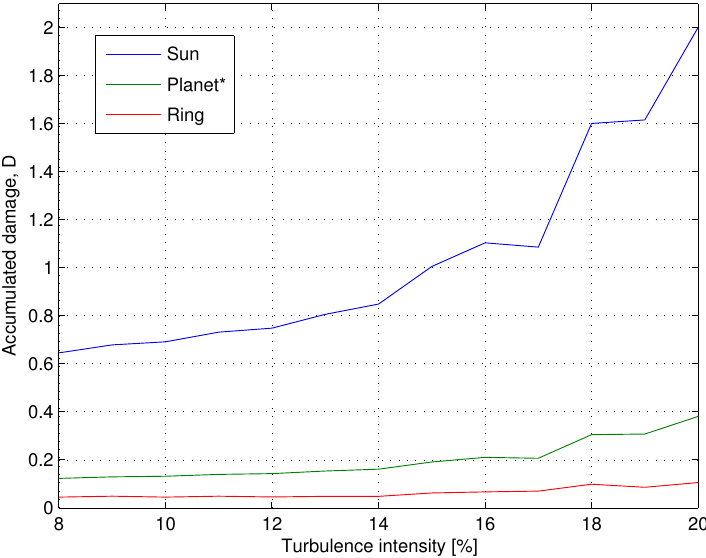
Figure 15: Accumulated fatigue on sun, planet and ring gears for lifetime operation (20